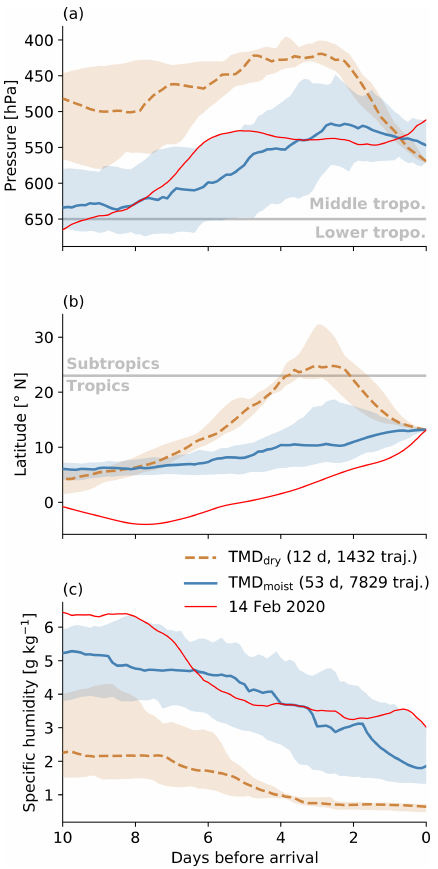
Figure 18. Time series along the TMD trajectories arriving at the BCO in the layer 650–300hPa on the 12 TMD days with negative (dashed brown) and 53 TMD days with positive (continuous blue) anomalies in IWV 650–300hPa during the quasi-climatological pe- riod. The variables shown are (a) pressure, (b) latitude, and (c) spe- cific humidity. Thick lines show the median value and the shading the 25th–75th percentile range. The mean of the TMD trajectories of 14 February 2020 is shown as a thin red line. Data: